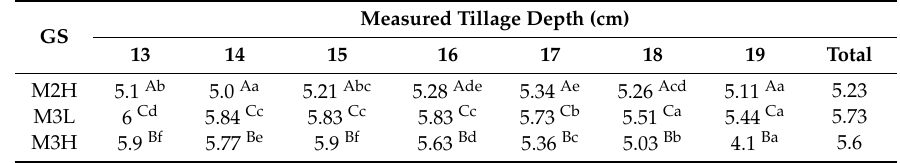
Table 6. Mean slip ratio (%) according to tillage depth and gear selection (GS).